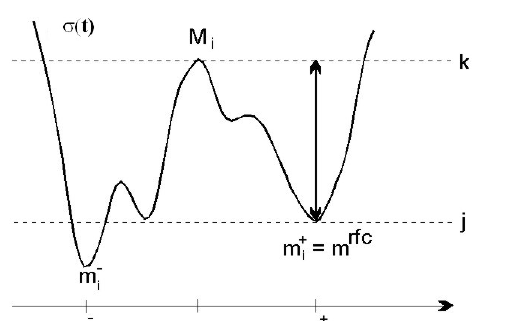
Fig. 6. Mathematical characterization of a rainflow